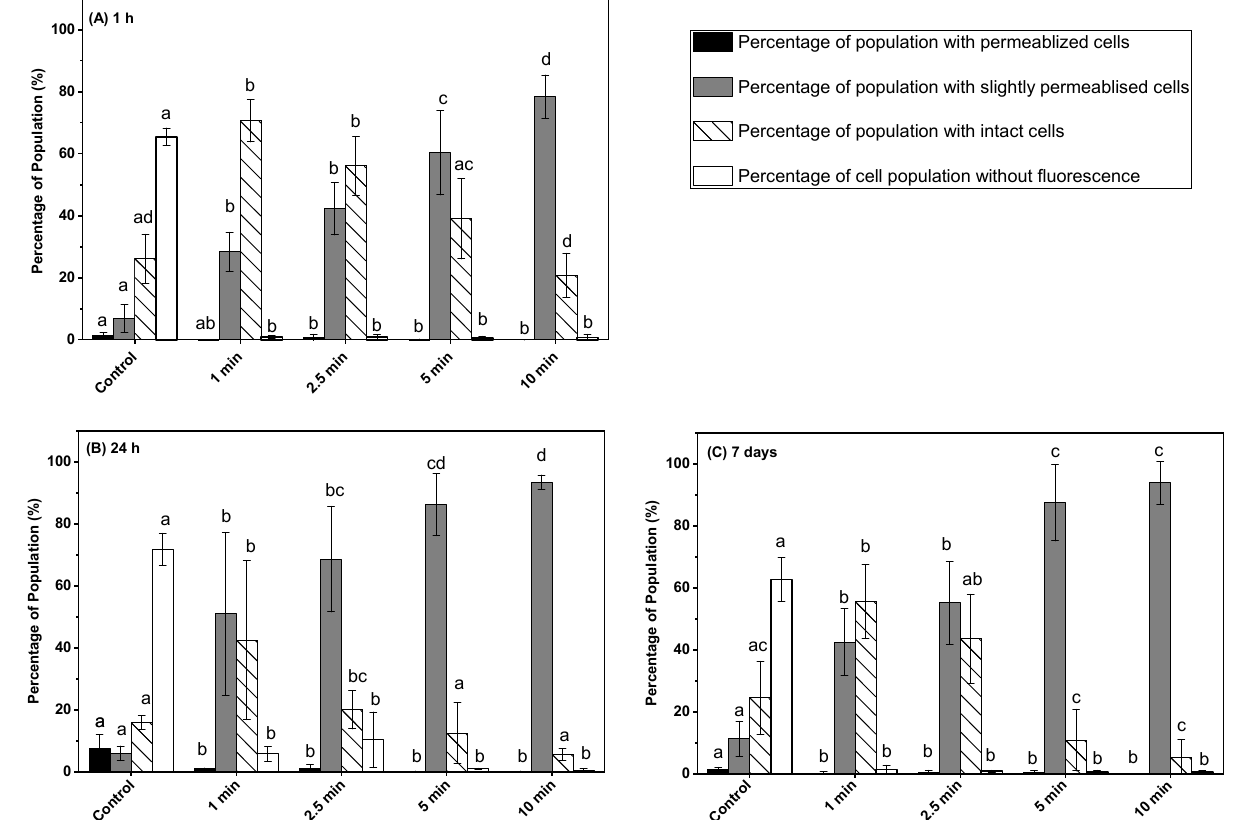
Figure 2. Membrane integrity measurements of L. monocytogenes cells on ham surface using SYTO9 and PI in combination after in-package ACP treatment storage at 4 °C for ( A ) 1 h, ( B ) 24 h, ( C ) 7 days. Black bar represents permeabilized cells (PI- fluorescence); grey bar represents slightly permeabilized cells (SYTO9 + PI fluorescence); white bar with hatch lines represents intact cells (SYTO 9 fluorescence); white bar represents cells without fluorescence. Data are shown as means ± standard deviations ( n = 3). Treatment means with different letters are significantly different.